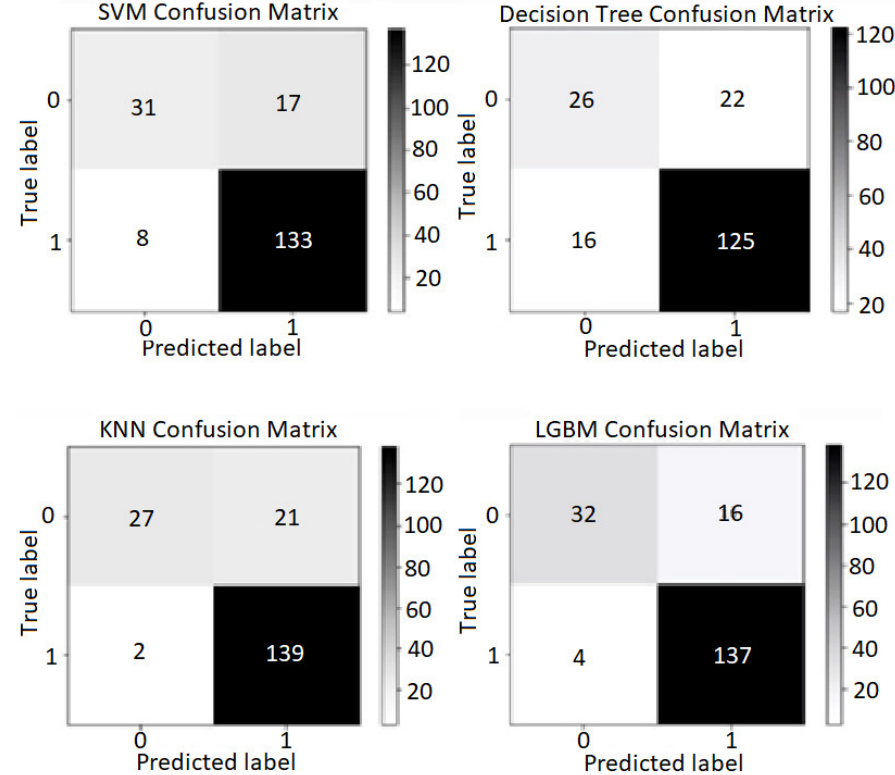
Figure 9. Confusion Matrix of the proposed model.